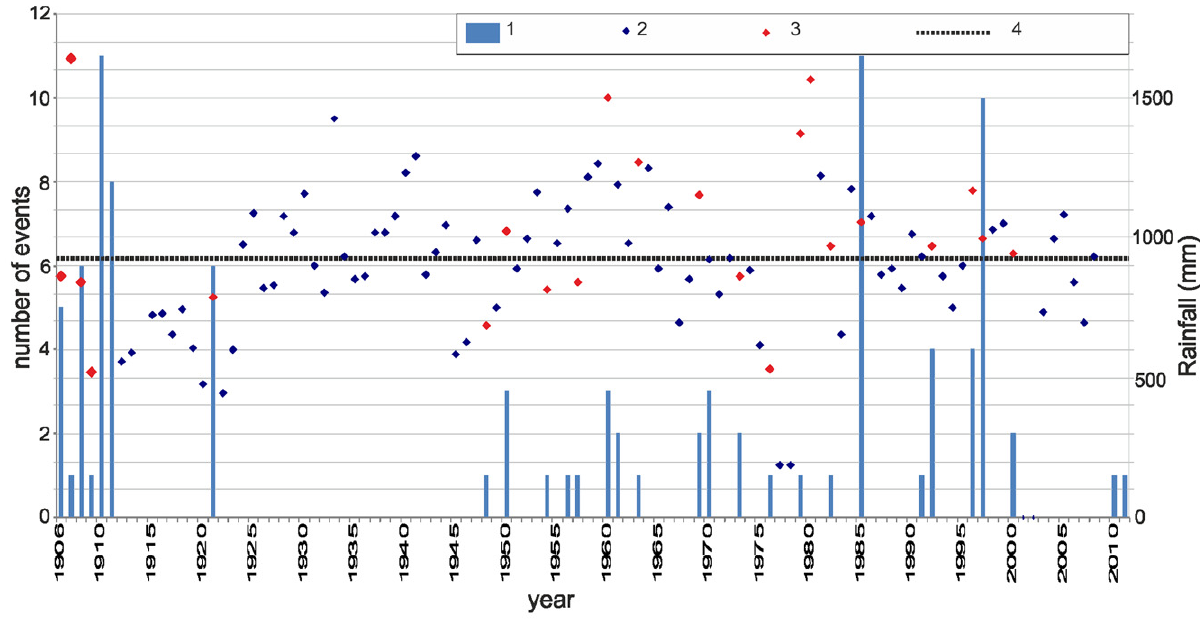
Figure 8. Yearly distribution of the events: 1) number of events; 2) cumulative yearly rainfall; 3) cumulative yearly rainfall relative to the year of the specific event; 4) average value of the yearly rainfall.